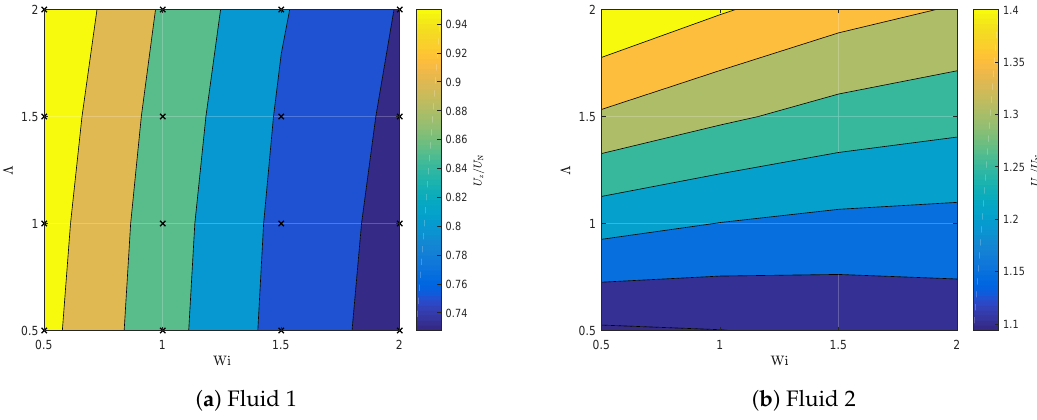
Figure 12. Contour plots of the sedimentation velocity of Fluid 1 and Fluid 2. Markers x indicate the data points; between these points, the data are interpolated using the MATLAB R (cid:13) function